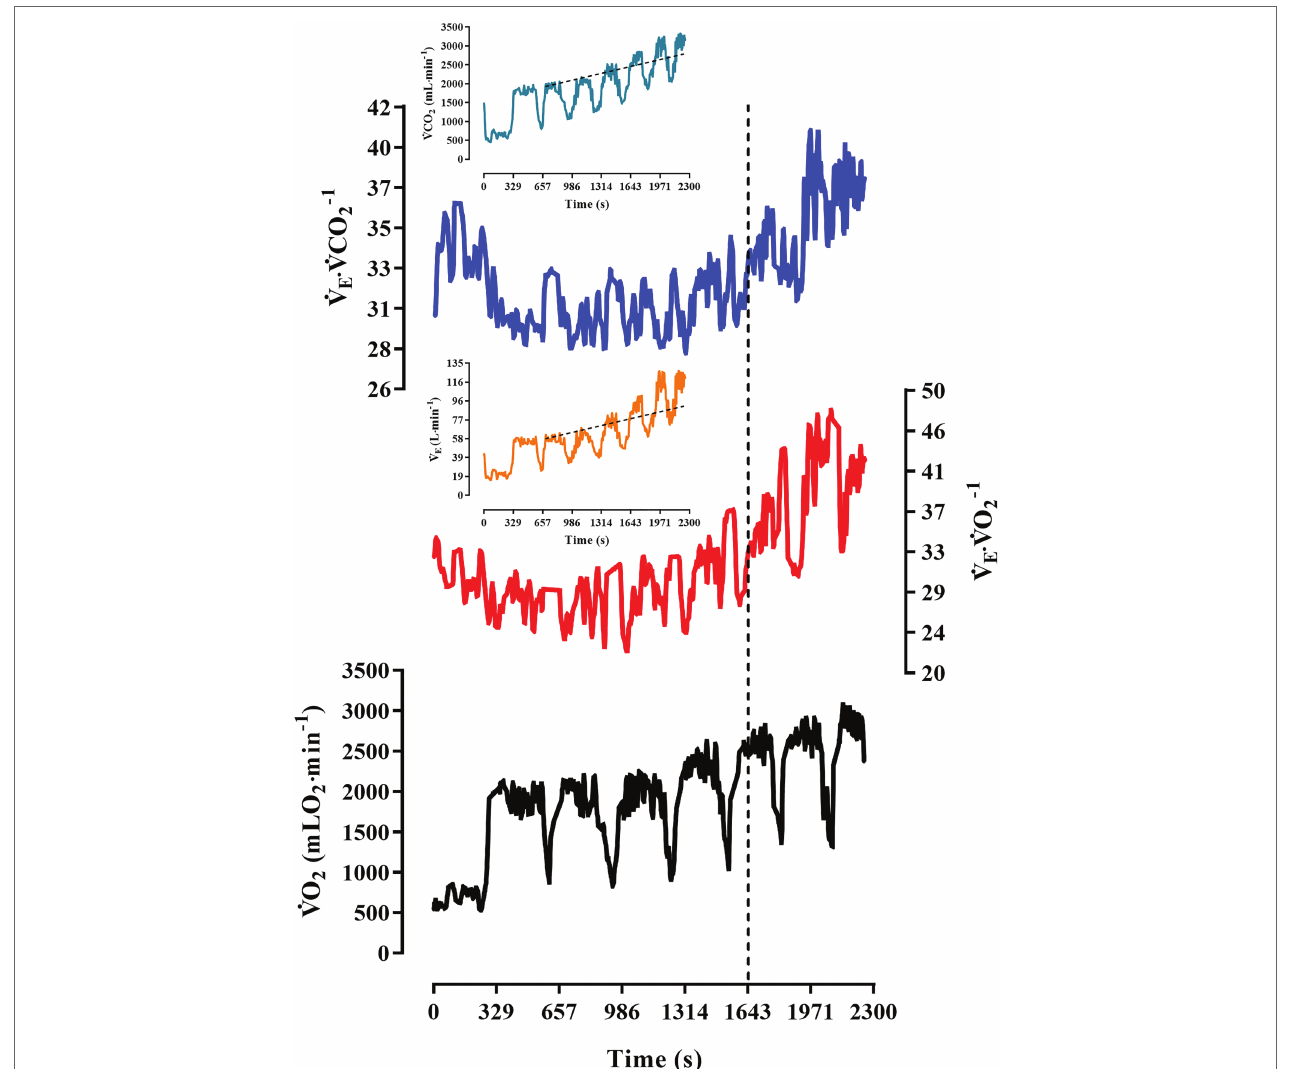
FIGURE 2 | Pulmonary ⩒O 2 and other gas-exchange responses during the incremental step test for a male participant. The vertical dashed line indicates VT 2 occurrence and the inclined dashed line illustrates isocapnic disturbance and ventilatory compensation. The progression for this male swimmer ranged from 67 to 100% ⩒O 2 peak, and time performance range was 265–161-s, respectively, from the first to the seventh